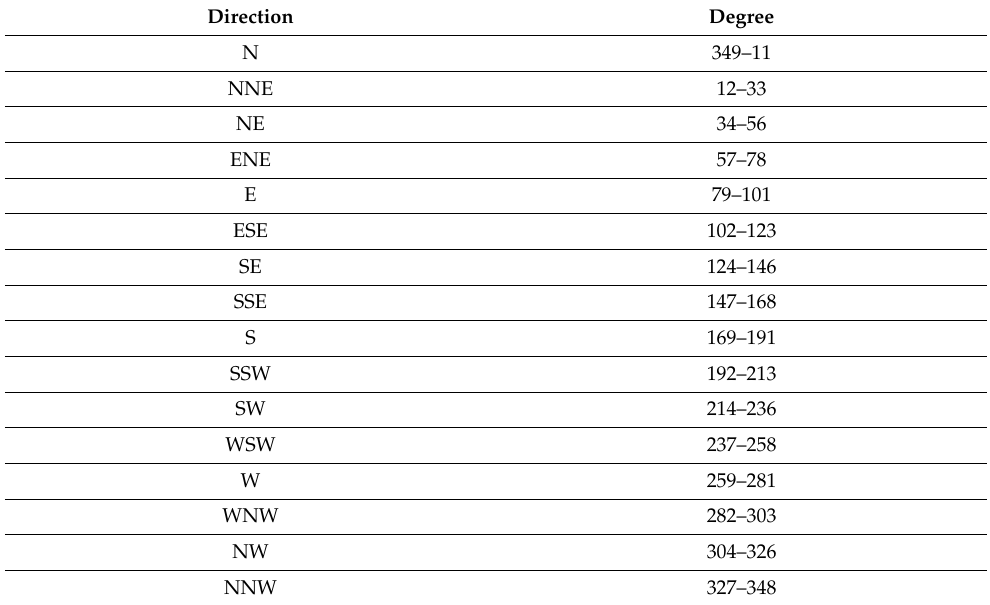
Table 4. Directions of wind in degree.